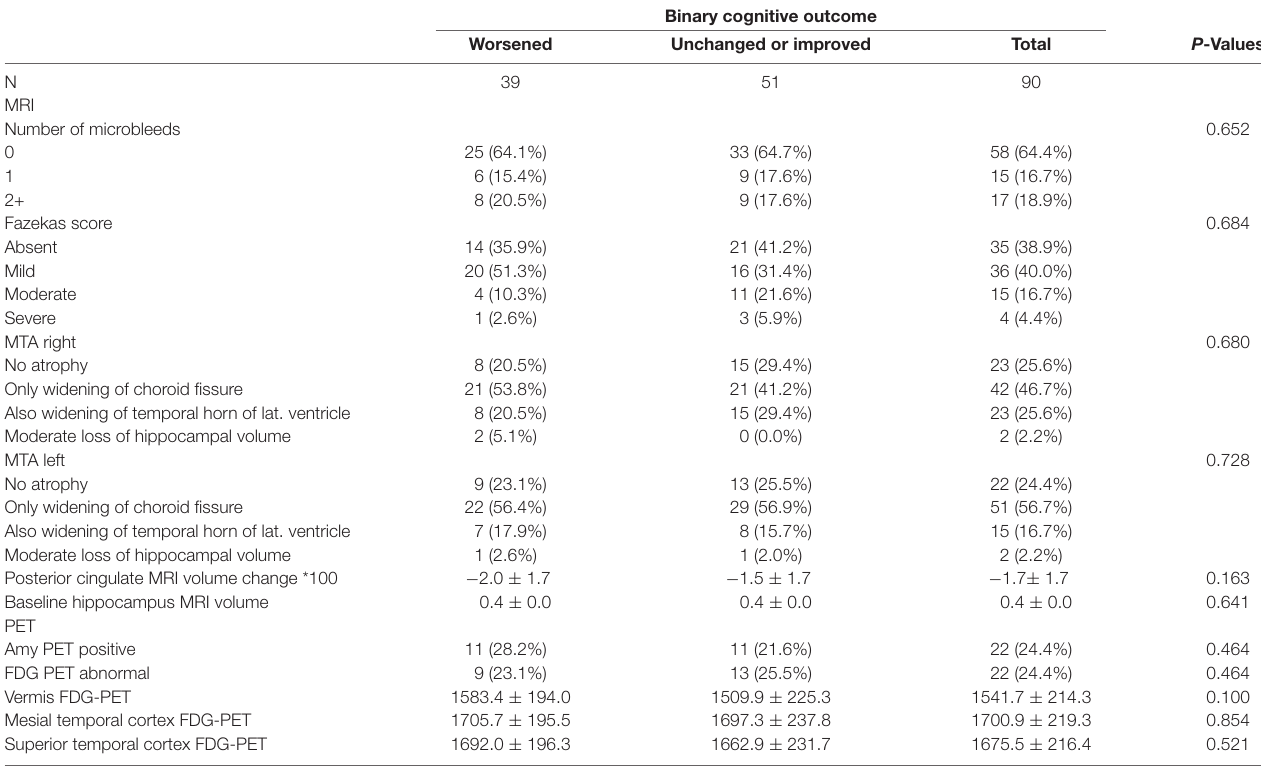
TABLE 2 | Demographic, clinical and imaging data by clinical evolution (cognitive worsening vs. unchanged or improved).